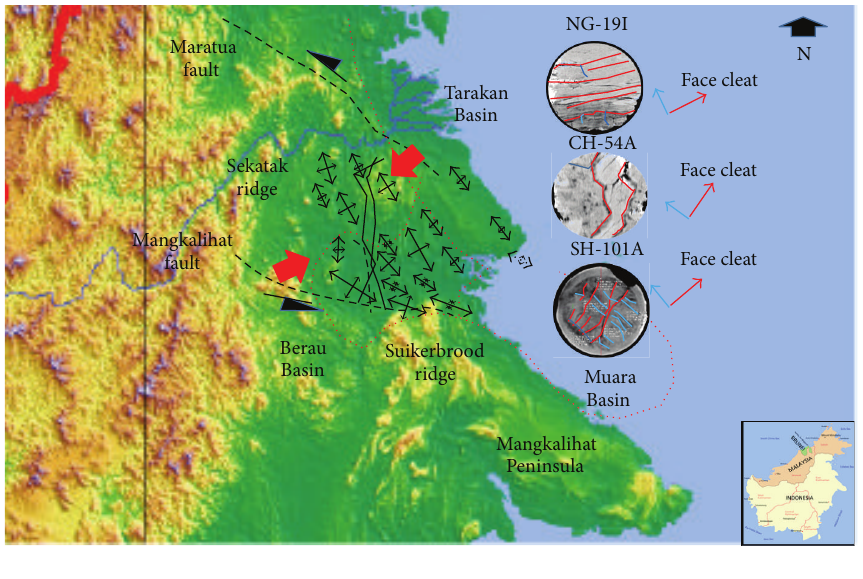
Figure 5: Structural geology (folds, faults, and cleats) arrangements in Berau Basin and CT scan image of representative coal samples.